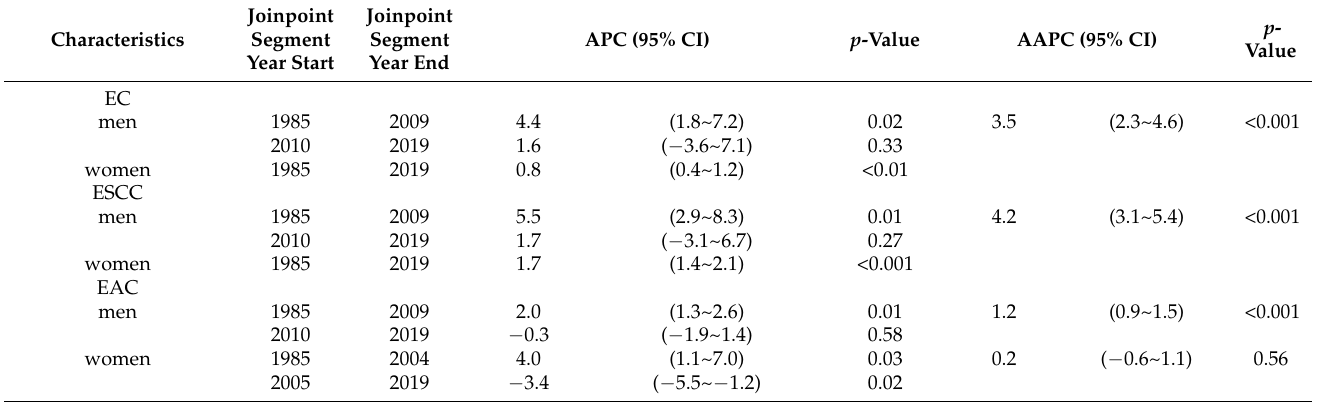
Table 1. Annual percent change (APC) and average annual percent change (AAPC) in EC, ESCC and EAC rates for the period 1985–2019, by